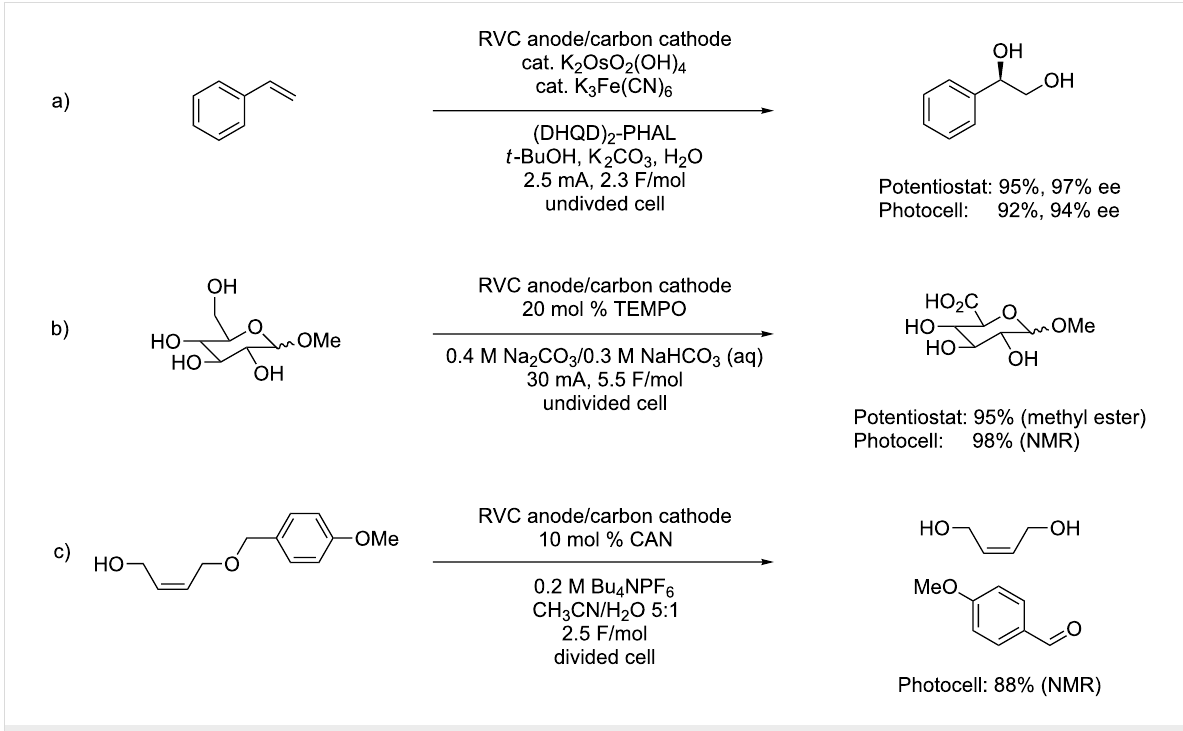
Scheme 4: Examples of solar-driven, indirect electrochemical oxidations.